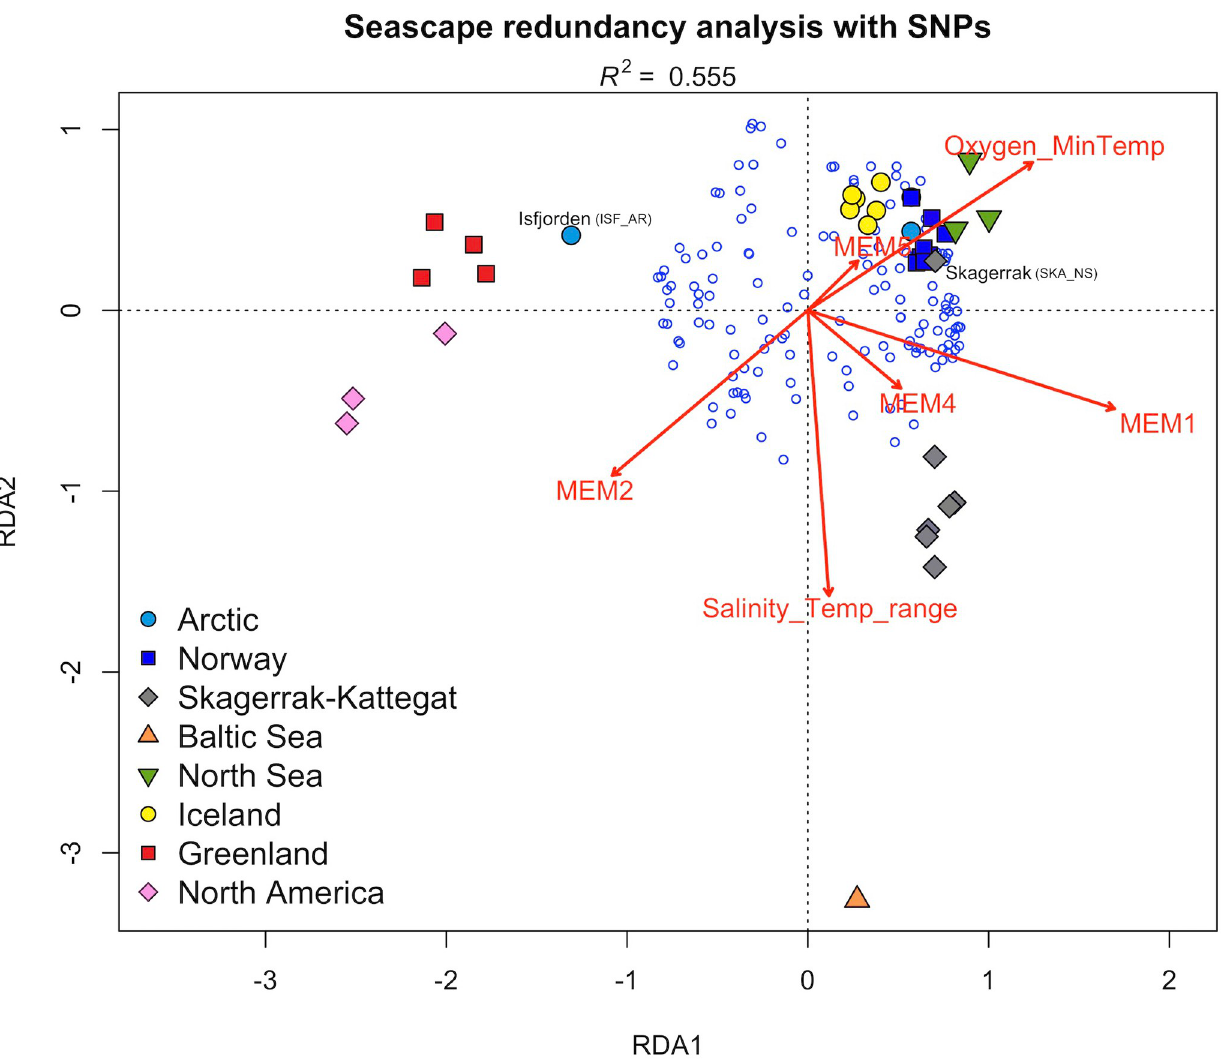
Fig 6. Seascape redundancy analysis of lumpfish ( Cyclopterus lumpus ). Moran Eigenvector’s Maps (MEMs) decompose spatial relationships among samples based on a spatial weighting matrix. Four MEMs, and two synthetic environmental variables (Salinity/Temperature range, Oxygen level/Minimum Temperature) were significantly associated ( p < 0.001) with the observed genetic structure. Together they explained 55.5% of the total variation. Samples are color-coded based on their geographic region as described in Table 1, with all Baltic Sea samples pooled as one. Isfjorden and Skagerrak samples are labeled as separated from other samples in their region. Small blue circles denote 139